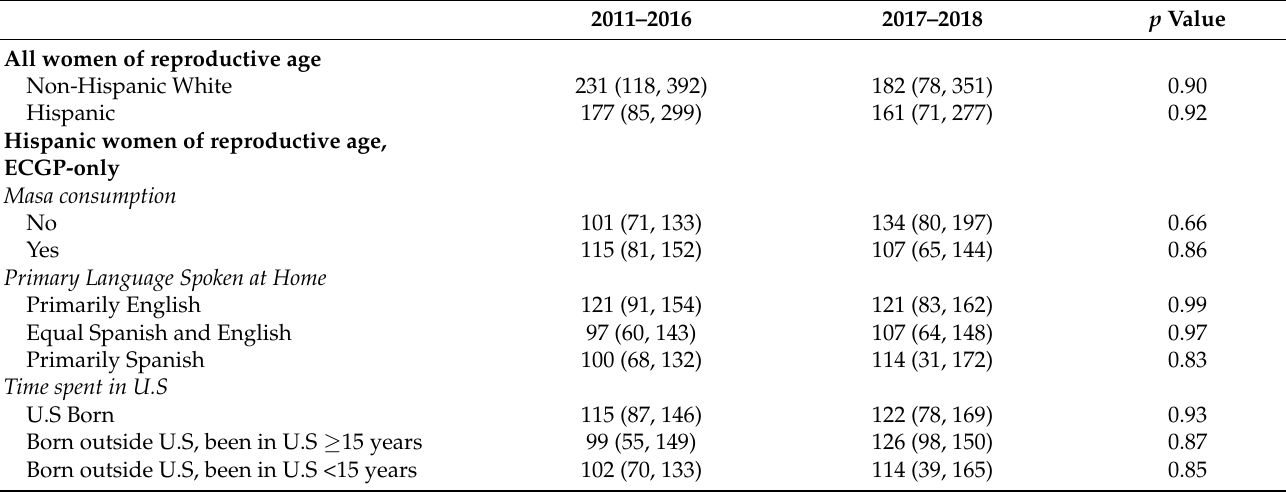
Table 2. Median usual intake (IQR) of folic acid (mcg) among women of reproductive age (12–49 years), NHANES a